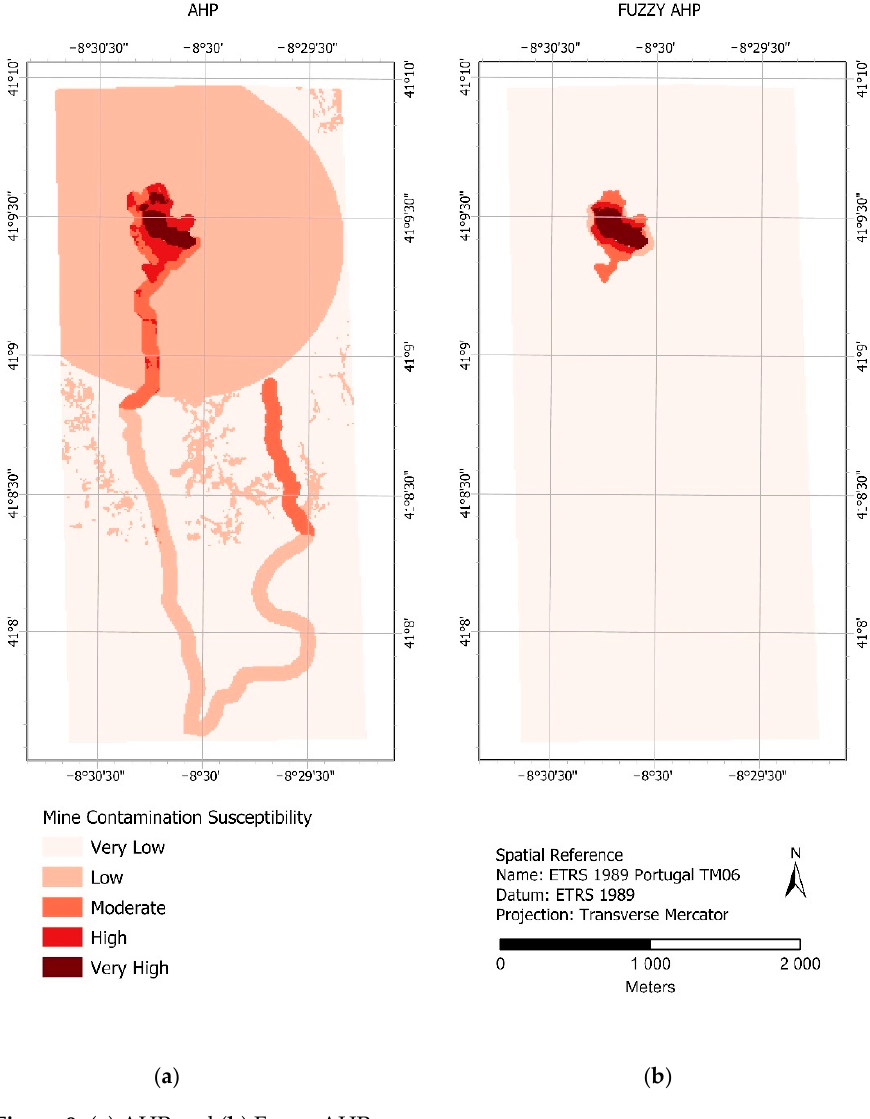
Figure 9. ( a ) AHP and ( b ) Fuzzy AHP maps.